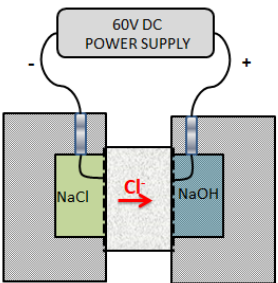
Figure 1. Experimental set up for the rapid chloride permeability test method.